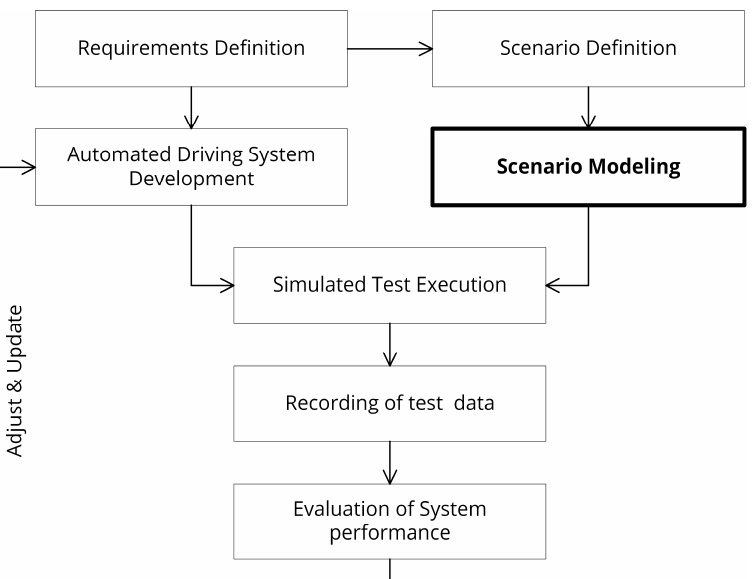
Figure 1. Positioning of the scenario modeling considered in this work in the scenario-based devel- opment process of automated traffic systems, roughly based on the process presented in [13]. The sub-process that is the main subject of this work is outlined with a bold